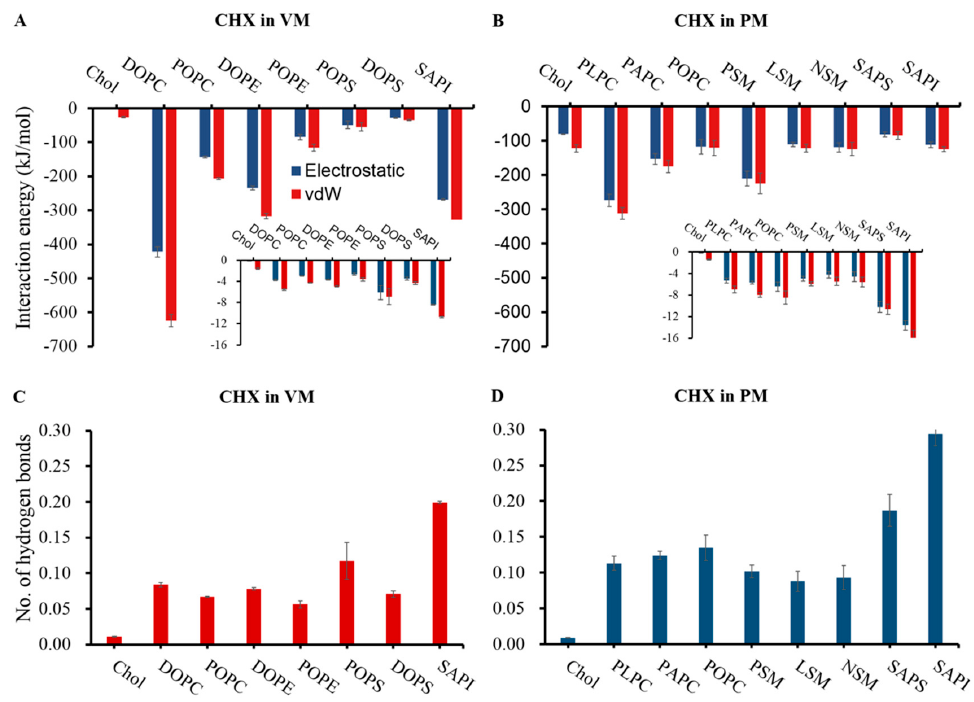
Figure 3. ( A , B ) Interaction energies of CHX with each lipid type of the viral membrane and plasma membrane models. Inset plots demonstrate the interaction energies normalized by lipid numbers. ( C , D ) Number of hydrogen bonds of CHX with each lipid type of the viral membrane and plasma membrane models, normalized with respect to lipid numbers.